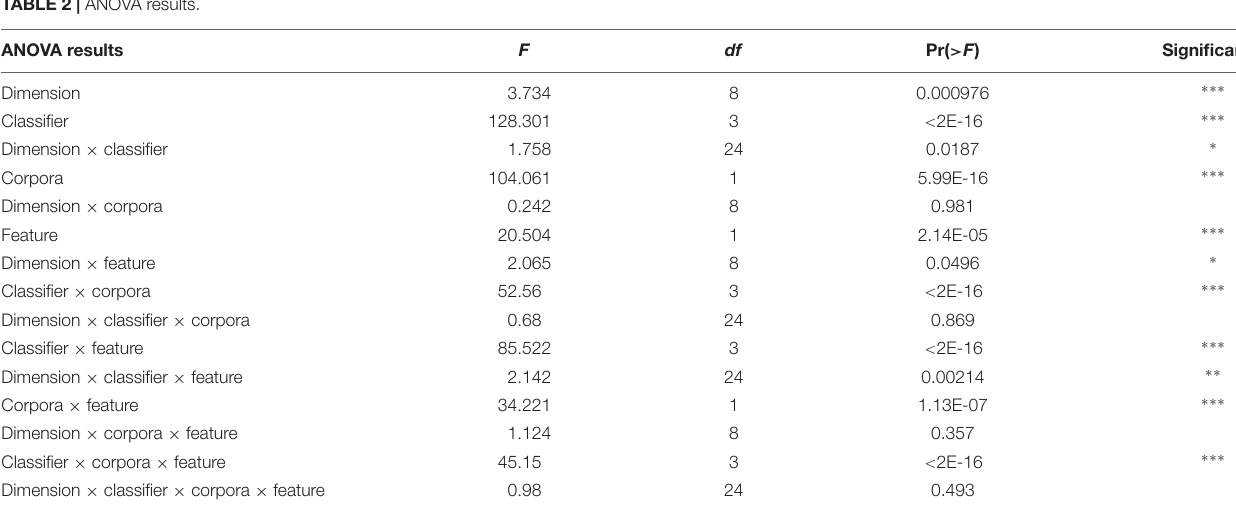
FIGURE 2 | Overall predictive performance across classifiers. Predictive performance evaluated as the average of Micro F1-scores for each combination of parameters over all CogPO dimensions provides an outlook of comparative performances. The combination of parameters with the highest performance occurred for bag of words , full-text , and logistic regression ; however, bag of words , full-text , and support vector classifier performed nearly equivalently. Performance levels for the Bernoulli naïve Bayes classifier, Cognitive Atlas feature space and full-text and abstract-only analyses were the same, indicating why it does not appear in the current figure. TABLE 2 | ANOVA